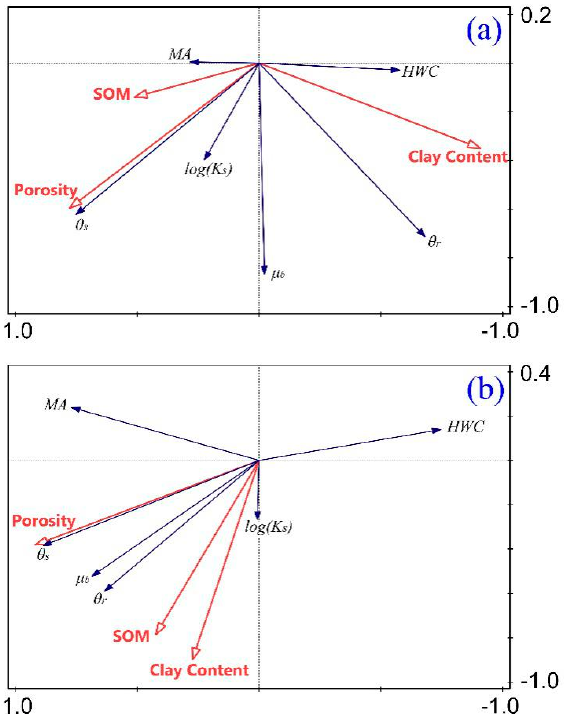
Figure 6. Redundancy analysis (RDA) ordination biplot showing the relationship between soil basic properties (red) and soil hydraulic properties (dark blue) in ( a ) CJP and ( b ) YL profiles. Porosity indicates total porosity; SOM, soil organic matter; HWC, hygroscopic water content; MA, macro-aggregates. The length of the arrows indicates relative importance; the direction of the arrows indicates the increase in relative content. The cosine of the angles between arrows (soil basic properties and soil hydraulic properties) indicates the degree of correlation between each pair of variables: sharp angles, positive correlations; right angles, no correlation; obtuse angles, negative correlations.